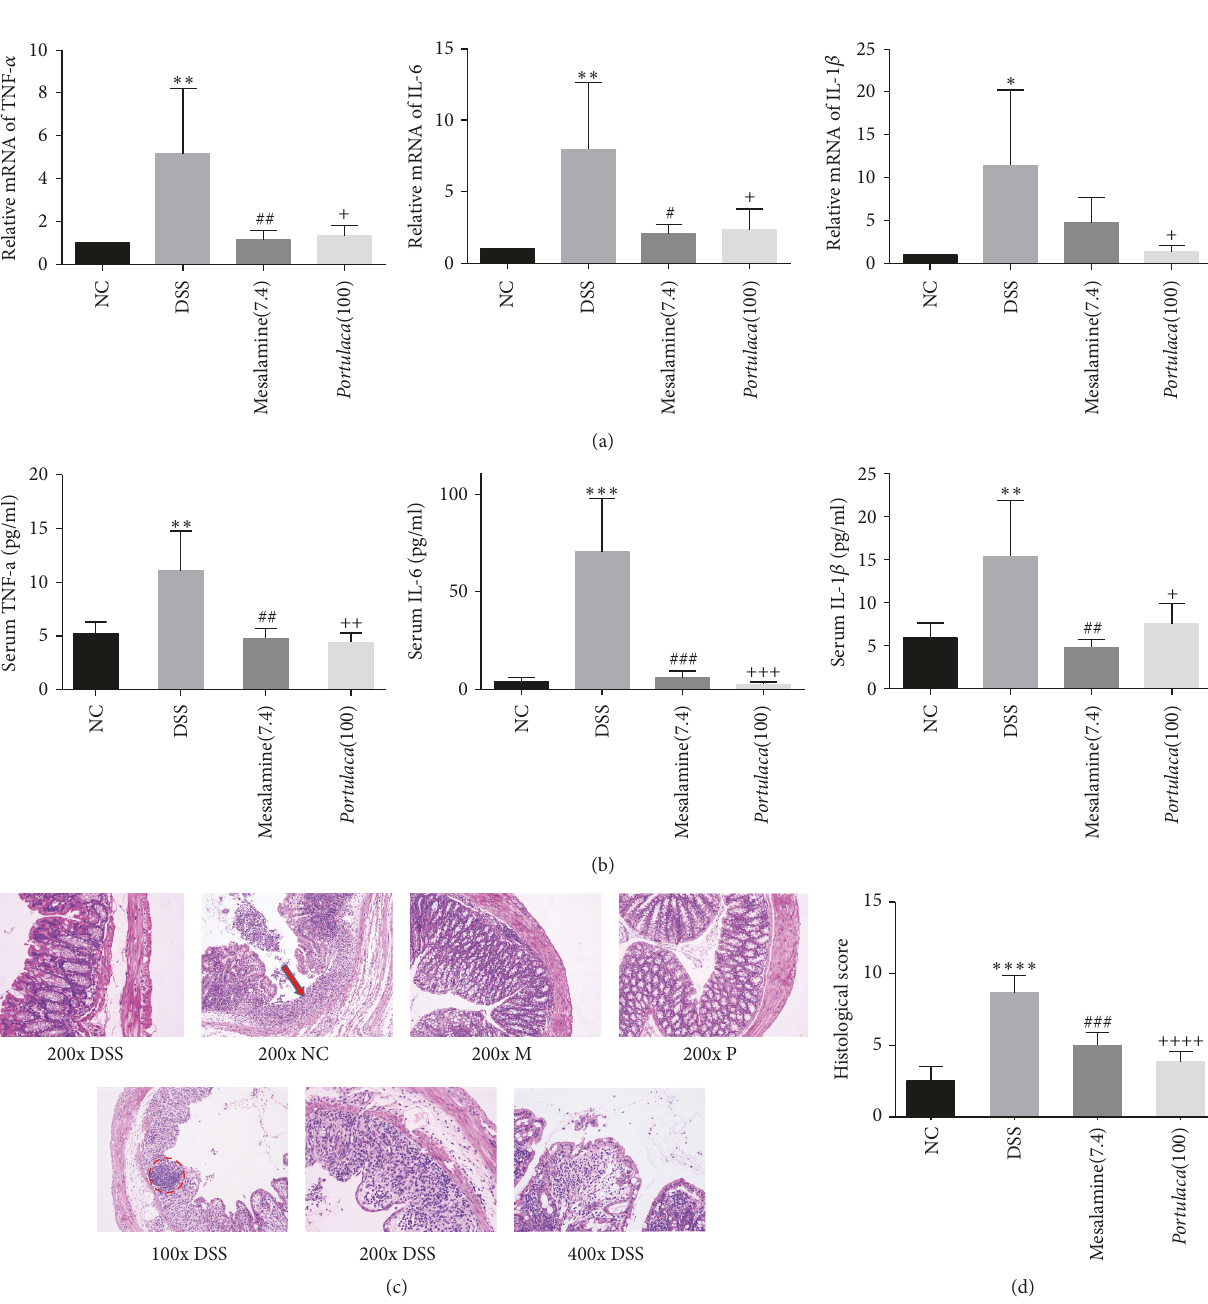
Figure 2: Effect of Portulaca extract on serum cytokines and tissue injury scores of DSS-induced acute colitis. Panel (a) indicates that the mRNA expressions of TNF- 𝛼 , IL-6, and IL-1 𝛽 were evaluated in each group with qRT- PCR. Panel (b) shows that the levels of TNF- 𝛼 , IL-6, and IL-1 𝛽 in serum were detected via ELISA assay. Panel (c) displays the H&E stained colon images (NC refers to negative control; DSS refers to DSS alone group; M refers to mesalamine group; P refers to Portulaca group). The dotted potion indicated the hyperplasia of lymphoid follicle; red arrow pointed the infiltration of inflammatory cells. Panel (d) indicates the histological scores of H&E stained colorectum images. (Data were presented as mean ± SD from six rats. ∗ indicates comparison between DSS and NC; # indicates comparison between mesalamine and DSS; + indicates the comparison between Portulaca and DSS. The number of symbols indicates significance of difference; for example, four symbols indicate 𝑝 < 0.0001 ; three symbols indicate 𝑝 < 0.001 ; two symbols indicate 𝑝 < 0.01 ; and one symbol indicates 𝑝 < 0.05